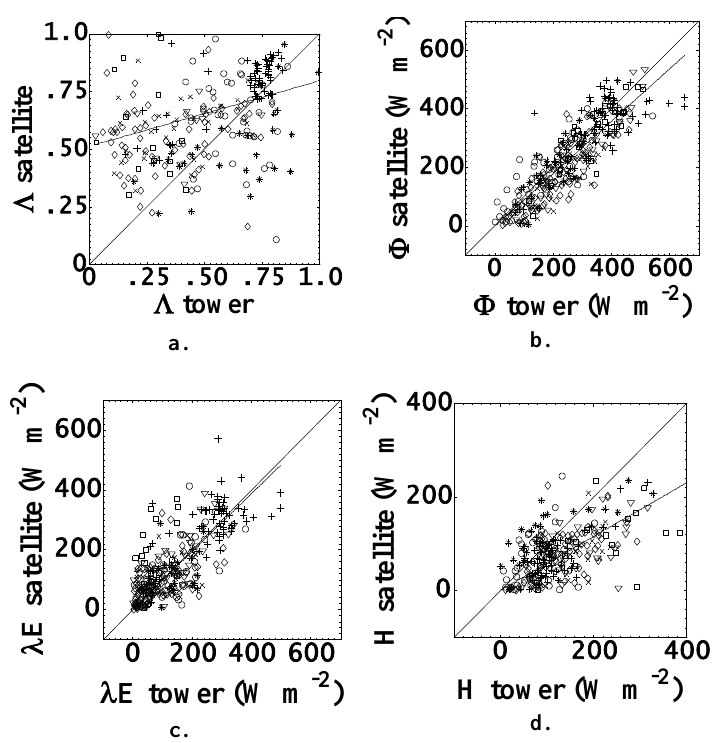
Figure 3. The evaluation of the AIRS derived monthly 13:30 hour components against their tower equivalent. a Evaporative fraction, Λ. Here, the solid regression line denotes Λ(satellite) = 0.31(±0.02)Λ(tower) + 0.49(±0.04). b Net available energy, Φ. Here, the solid regression line denotes Φ(satellite) = 0.90 (±0.03)Φ(tower) – 2.43(±8.19) (see Mallick et al., 2014). c latent heat flux, λE. d Sensible heat flux, H. For regression statistics see Table 3. 1:1 line is shown for reference. EBF = Evergreen broadleaf forest, MF = Mixed forest, GRA = Grassland, CRO = 835 Cropland, ENF = Evergreen needleleaf forest, DBF = Deciduous broadleaf forest, SAV = Savanna